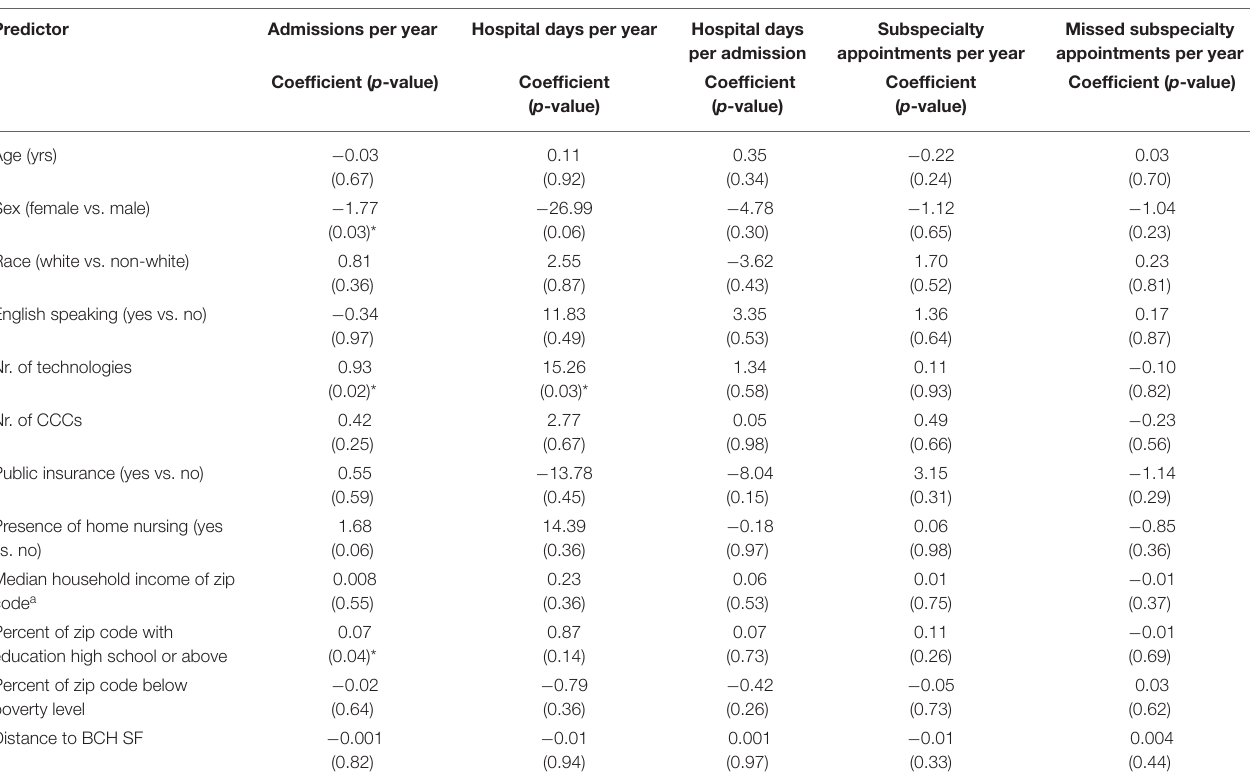
TABLE 3 | Univariable models for different risk factors for increased healthcare utilization in the FLIGHT patient group ( n = 64).